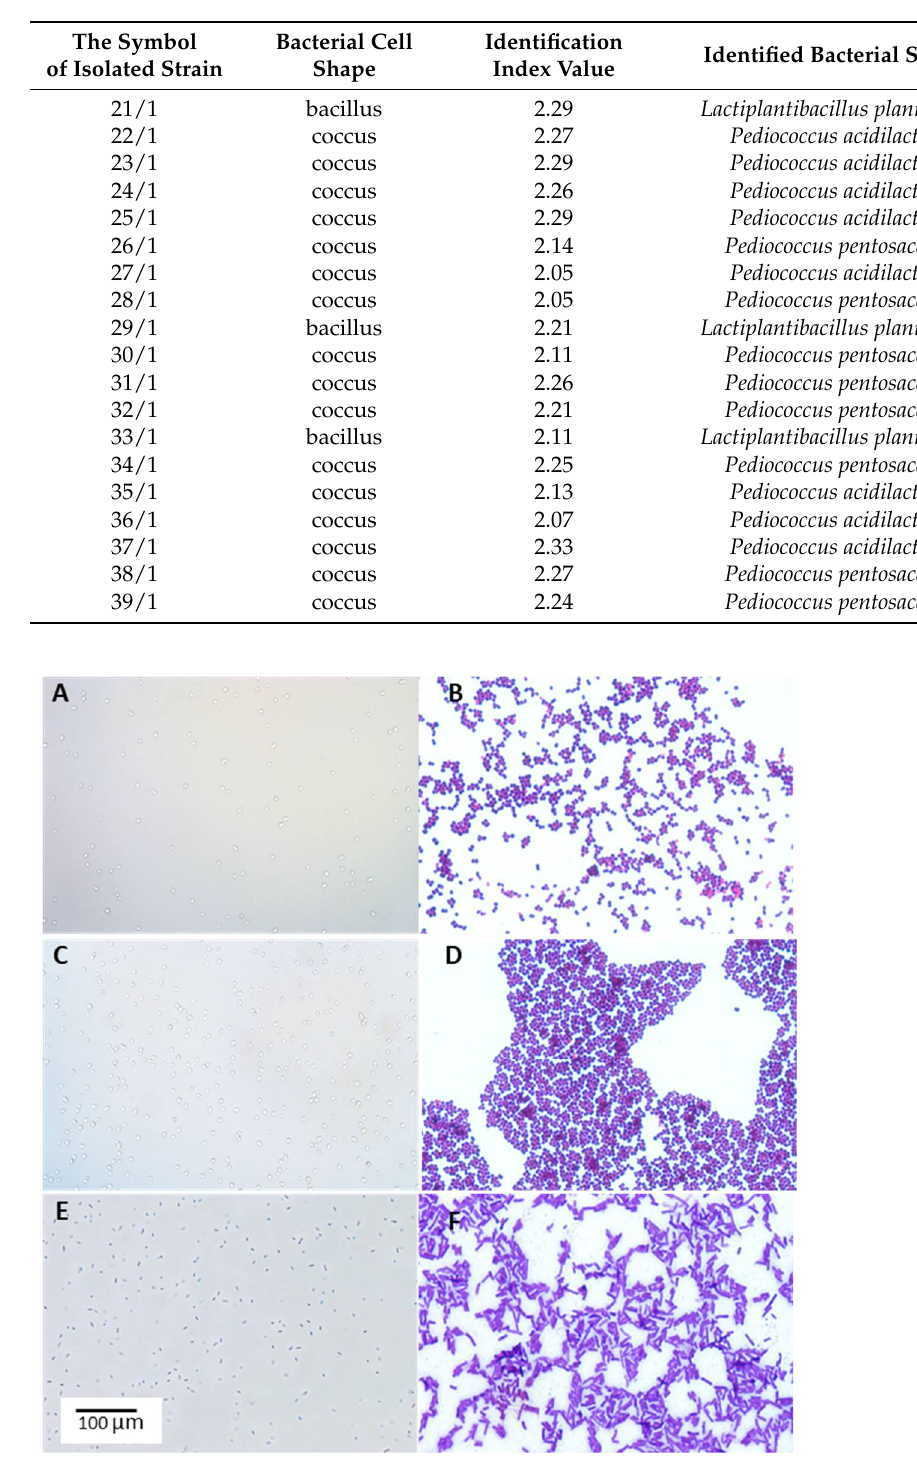
Figure 1. Example microphotographs of lactic acid bacteria isolates from honeybee environment.